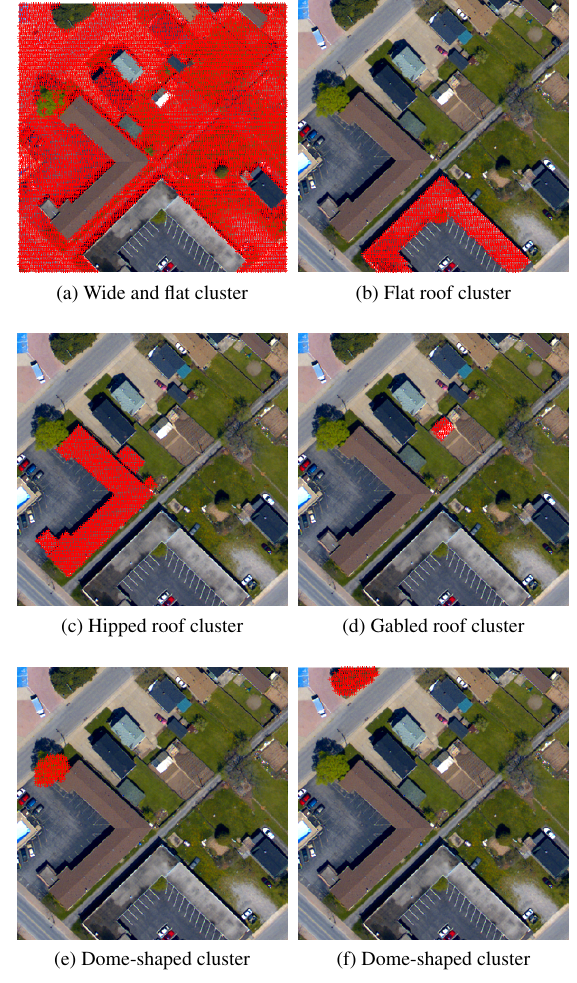
Figure 5: Outputs of DBSCAN and various cluster